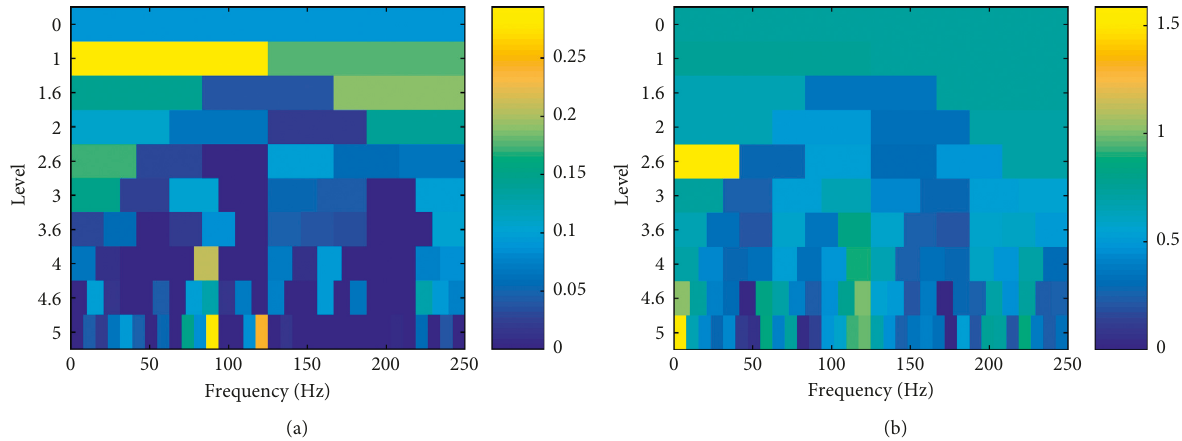
B w (cid:31) 41.6667Hz;